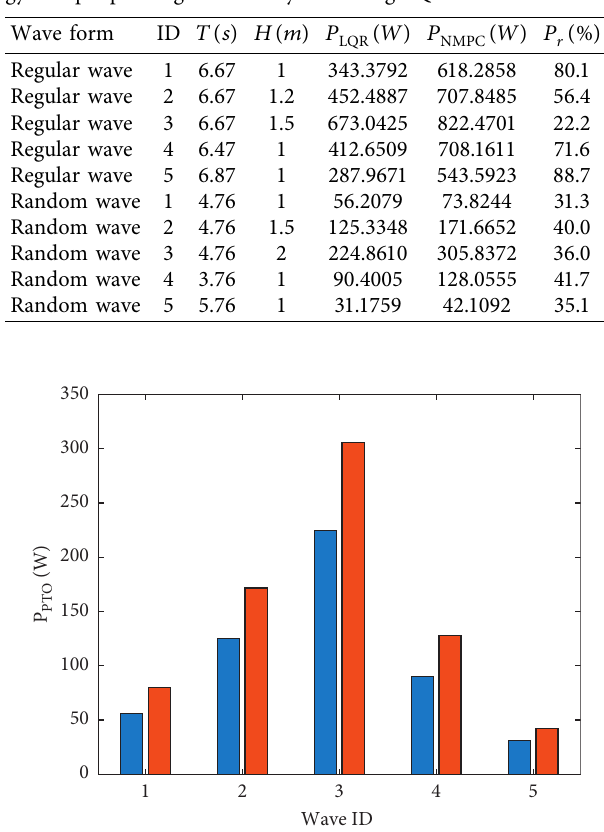
Table 2: The energy output performance comparison of the inertial gyroscopic power generation system using LQR and NMPC.